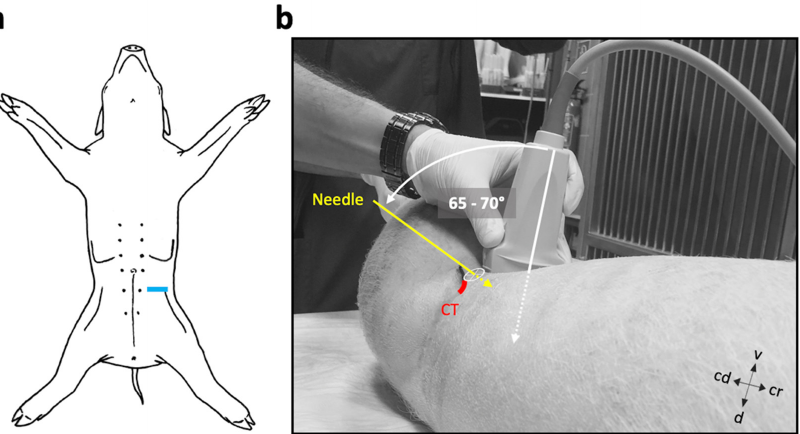
Figure 1. Ultrasound-transducer positioning and suggested insertion direction of the PNB-needle. ( a ) Transducer position in ventral view. ( b ) The US beam is directed dorsally and slightly medially; the orientation marker on the transducer faces lateral. The needle was inserted from lateral, entering 1 cm caudal and ventral to the coxal tuber (CT) of os ilium, using an in-plane technique and displayed angle. cr, cranial; cd, caudal; v, ventral; d, dorsal.